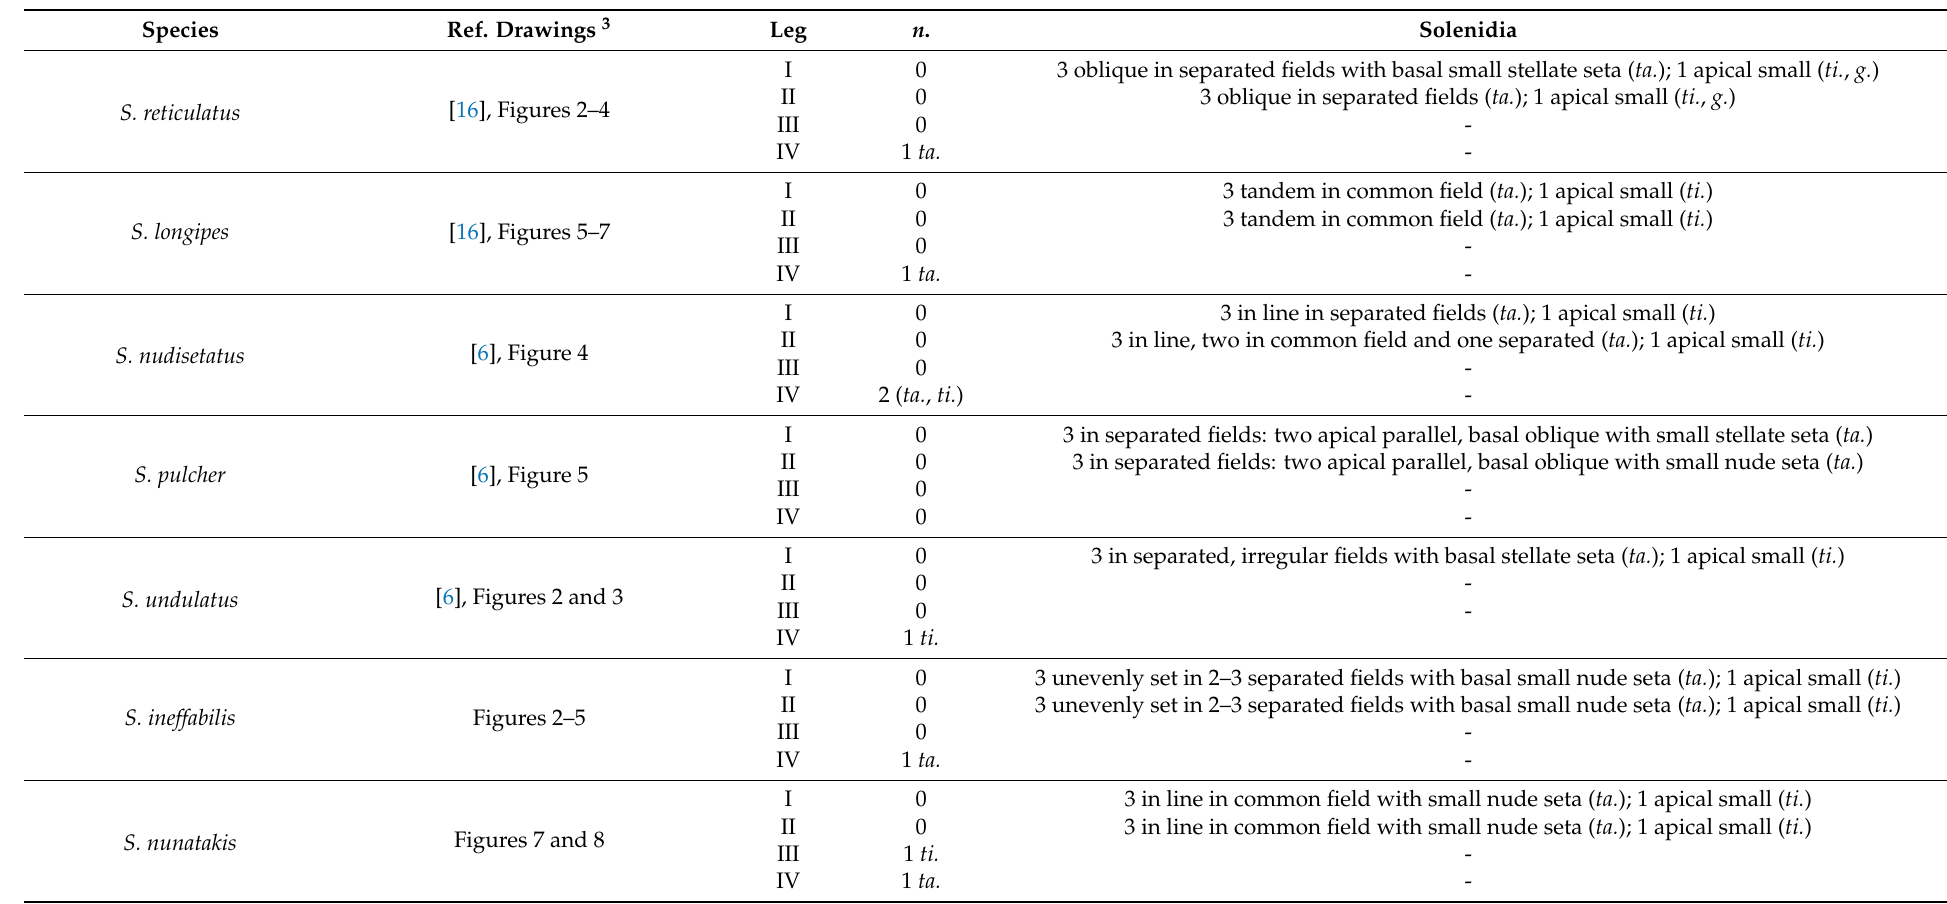
3 Figures from reference articles used for the